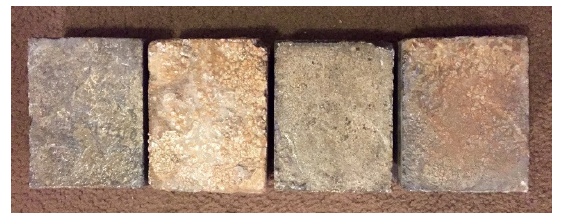
Fig. 15: Materials and Set Up used for